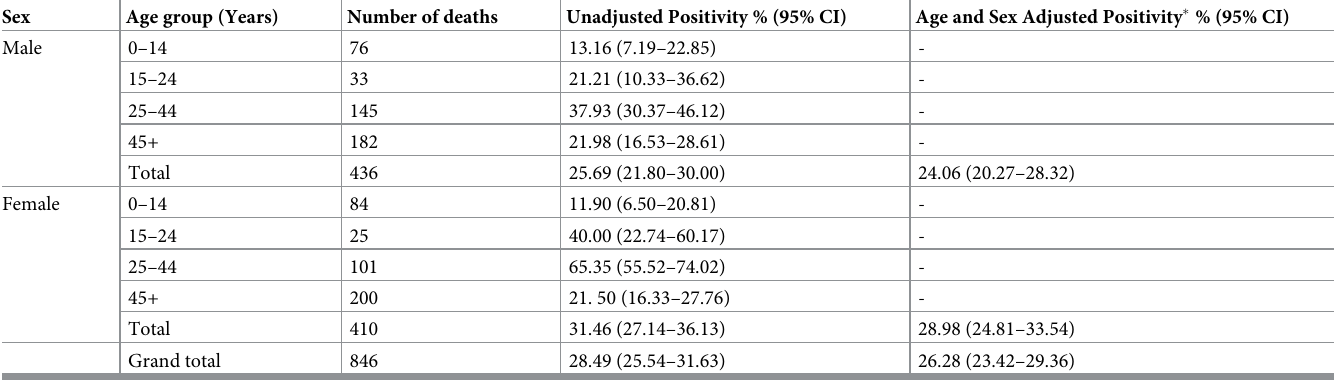
Table 1. Unadjusted and adjusted HIV prevalence among Kisumu decedents by age and sex (N =